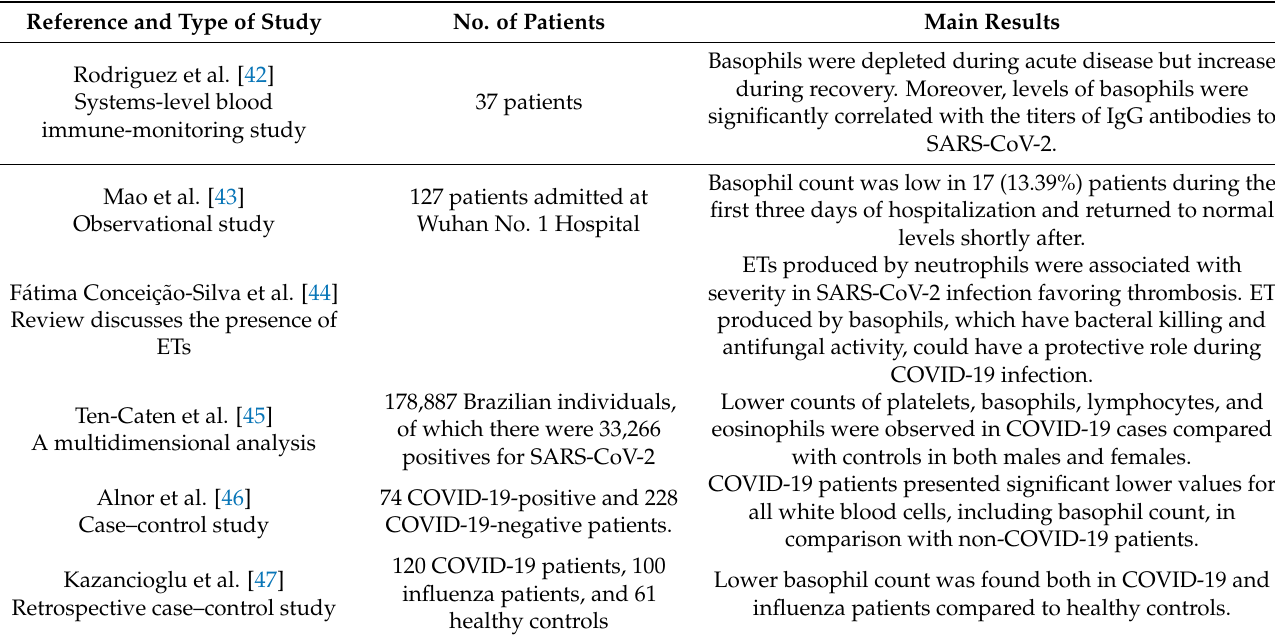
Table 1. Summary of the literature with the main findings of the basophil and mast cell involvement in COVID-19